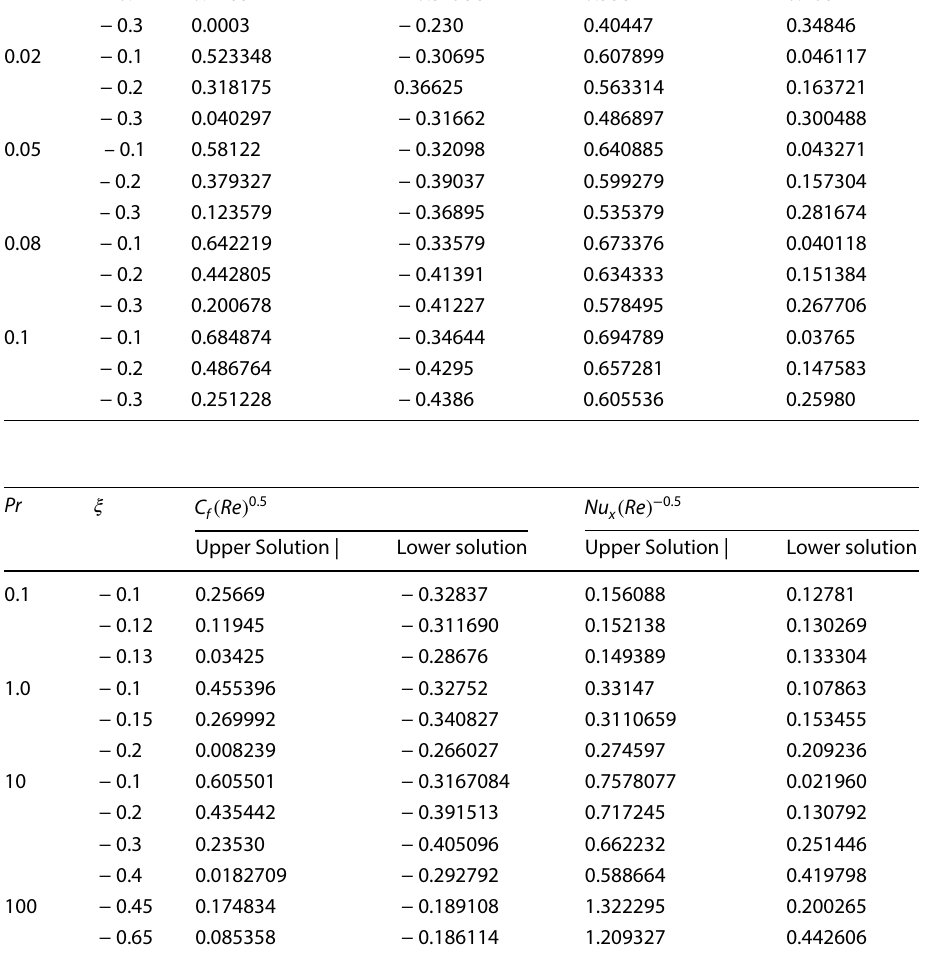
Table 5 Results for C f for various 𝜙 , 𝜉 for buoyancy- induced opposing flow ( 𝜆 0) for fixed Pr =6.7